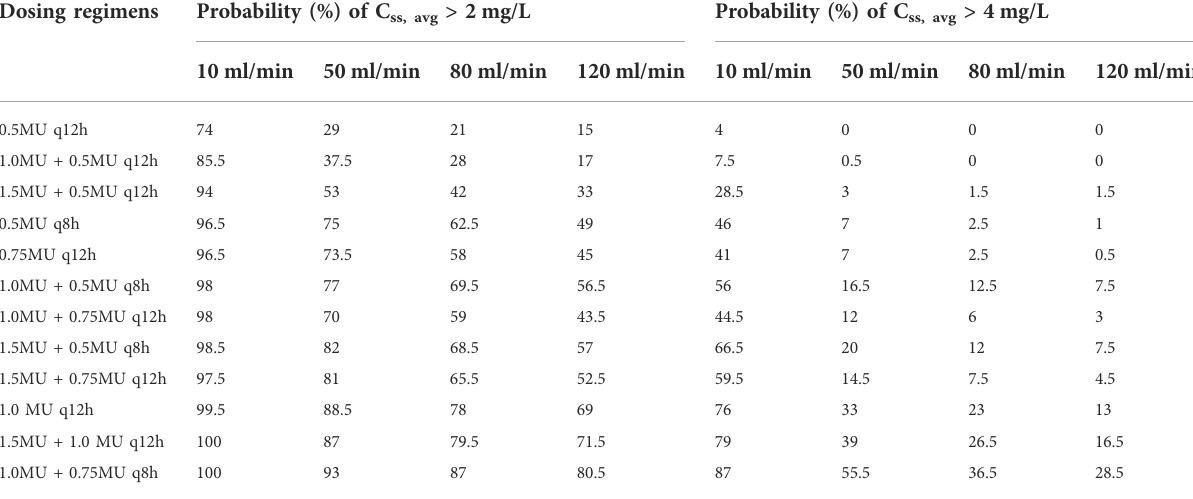
TABLE 3 Probability (%) of target Css, avg > 2 mg/L or Css, avg > 4 mg/L for different colistin sulfate regimens. Dosing